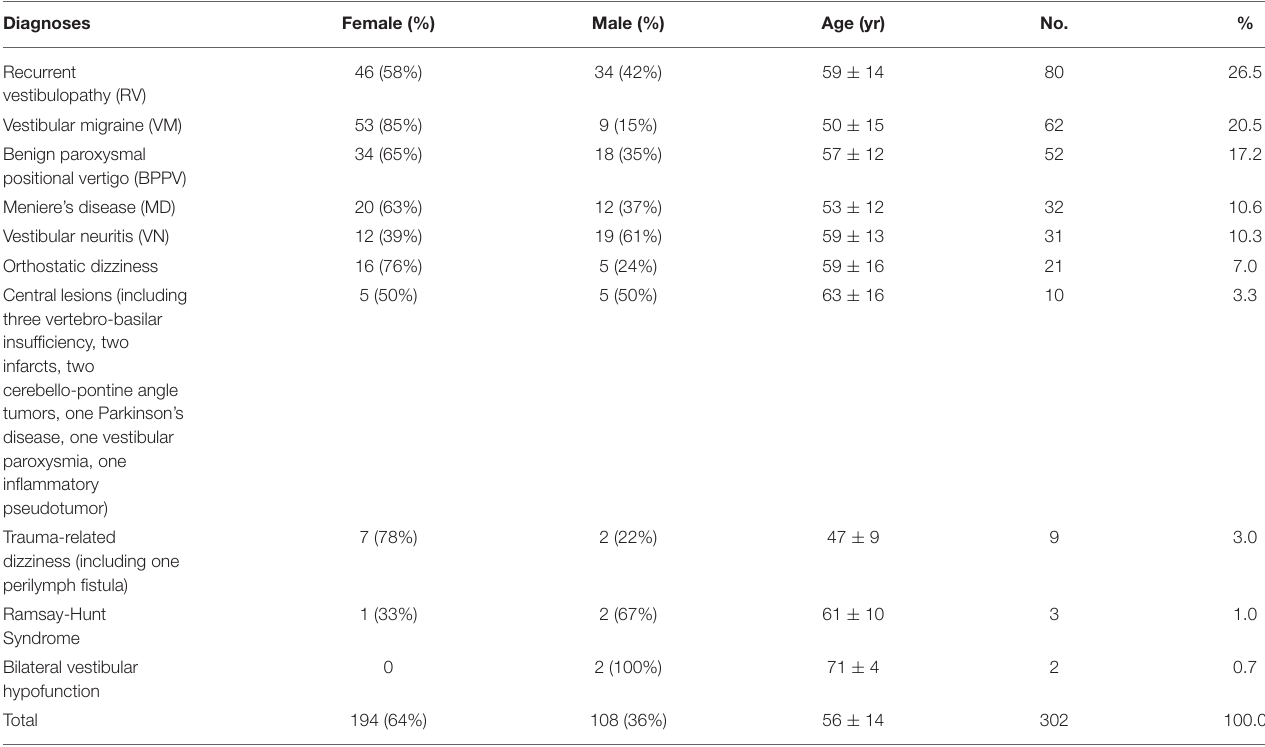
TABLE 2 | Incidence of diagnoses causing dizziness among the 302 dizzy patients in a neurotologic outpatient clinic. Diagnoses Female (%) Male (%) Age (yr)